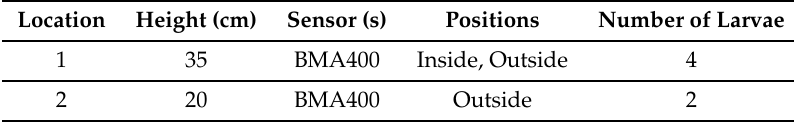
Table 2. Experimental Settings for Data